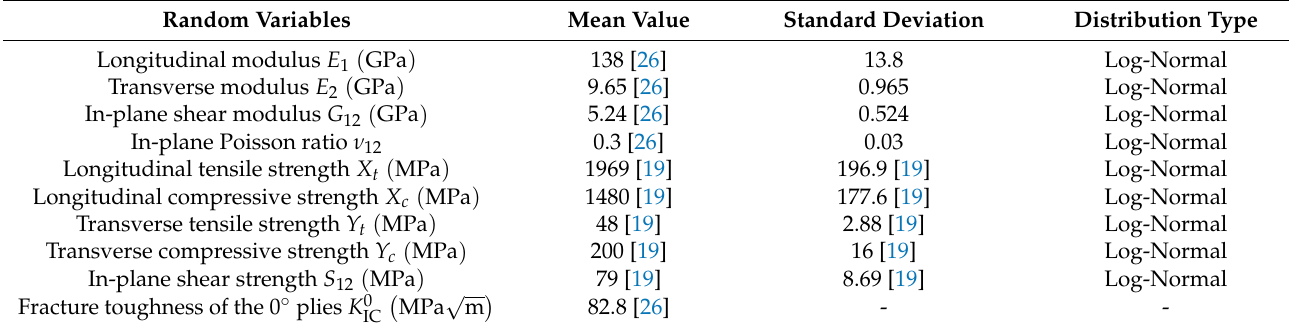
Table 3. Statistical information for AS4/3501-6.